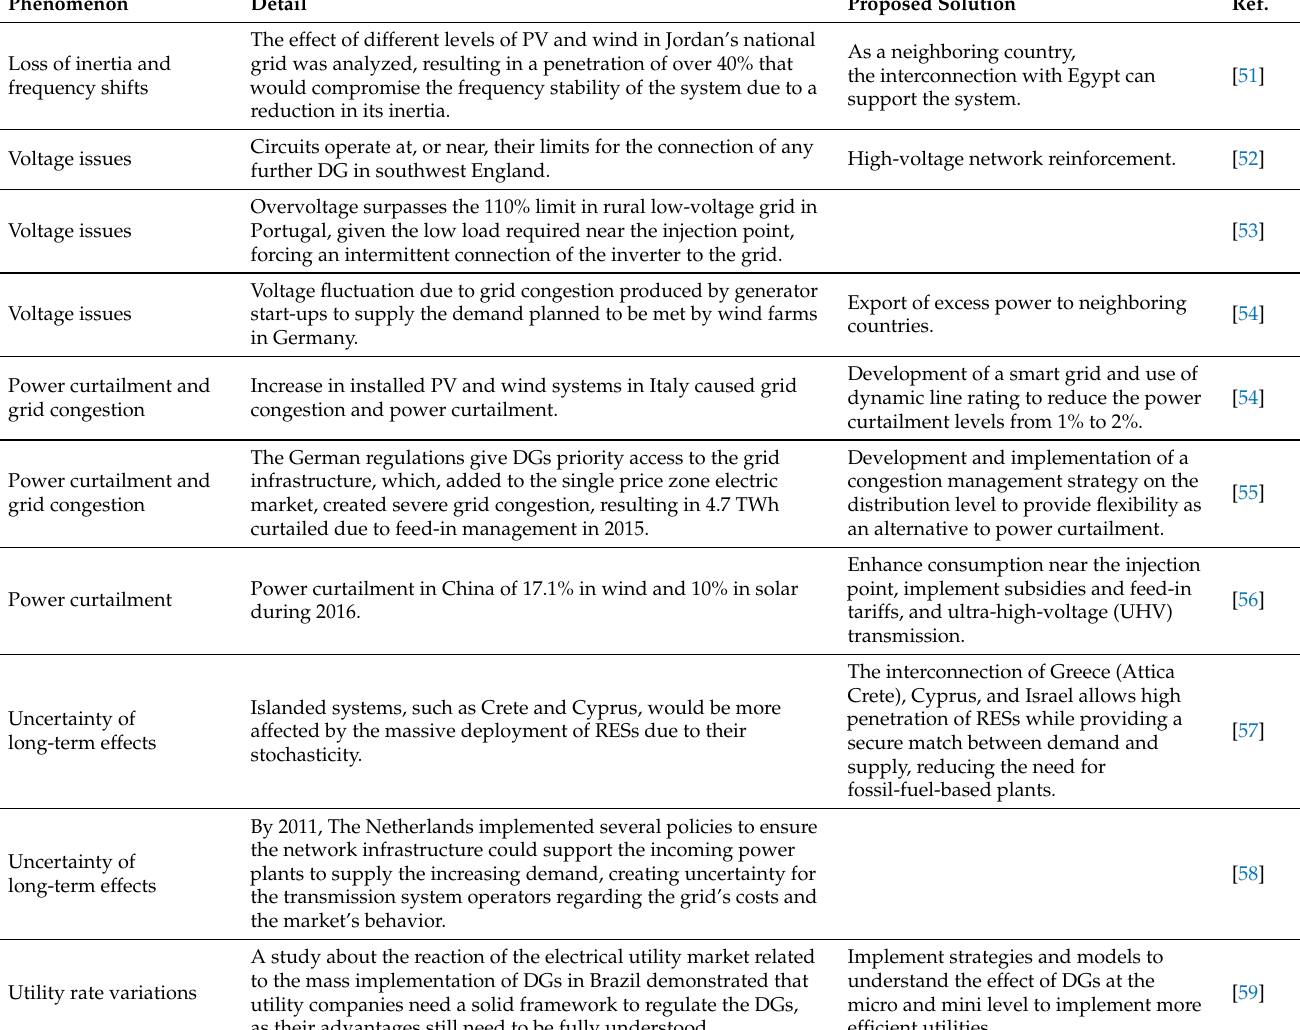
Table 2. Reported unexpected outcomes on grids due unplanned DG